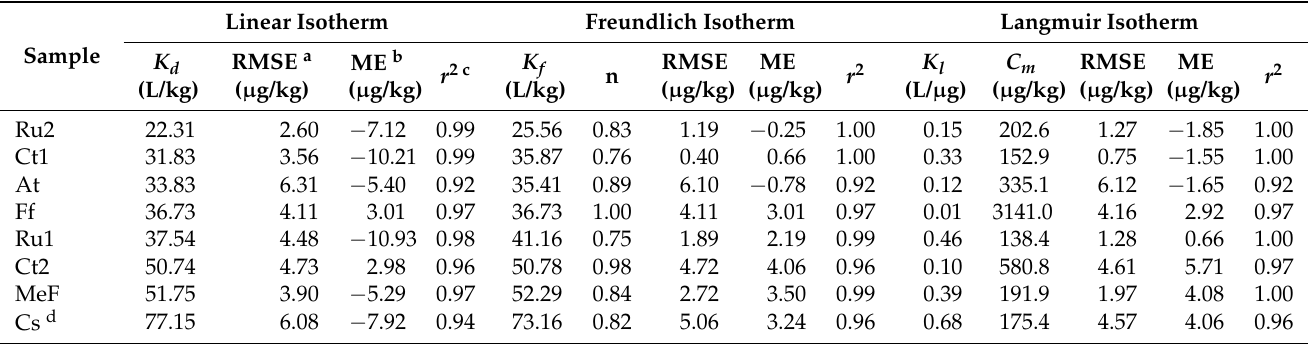
Table 4. Linear, Freundlich, and Langmuir isotherm parameters and goodness-of-fit